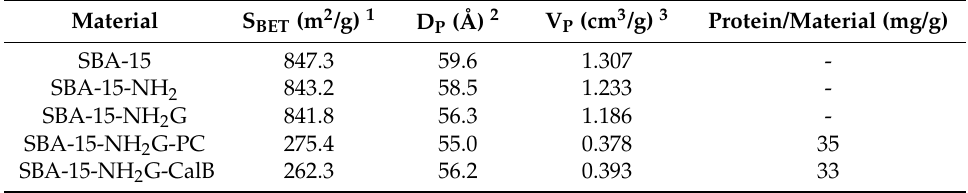
Table 1. Textural properties and enzyme fixed with synthesized mesoporous materials.